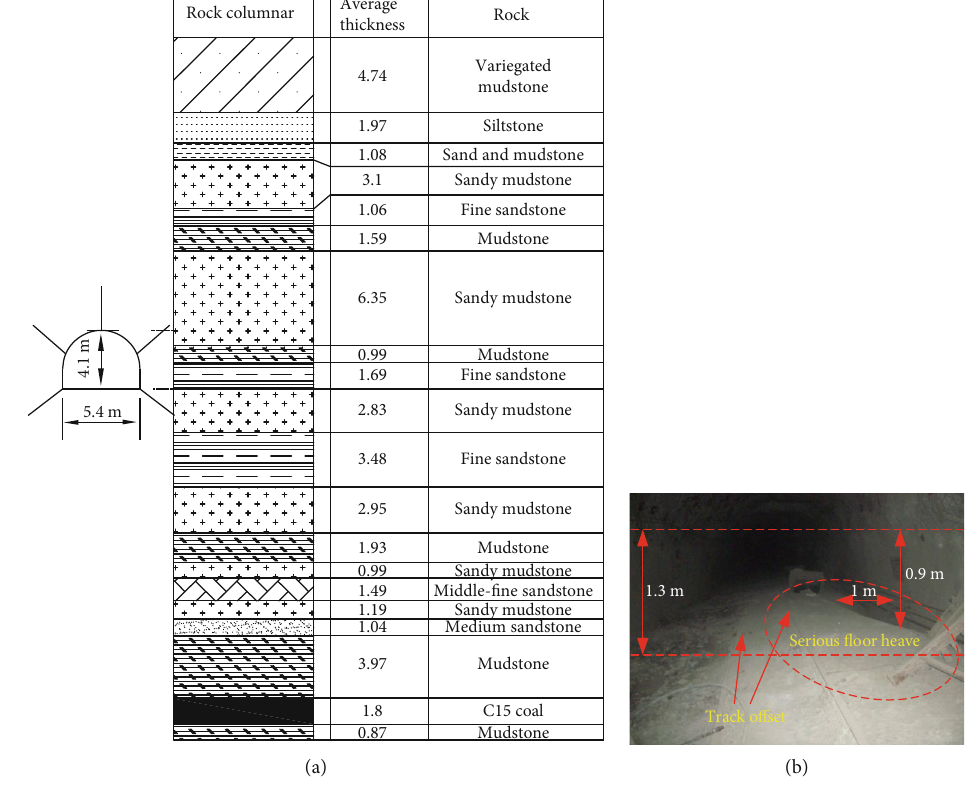
Figure 1: Roadway overview. (a) Borehole columnar section. (b) Floor heave fi gure.